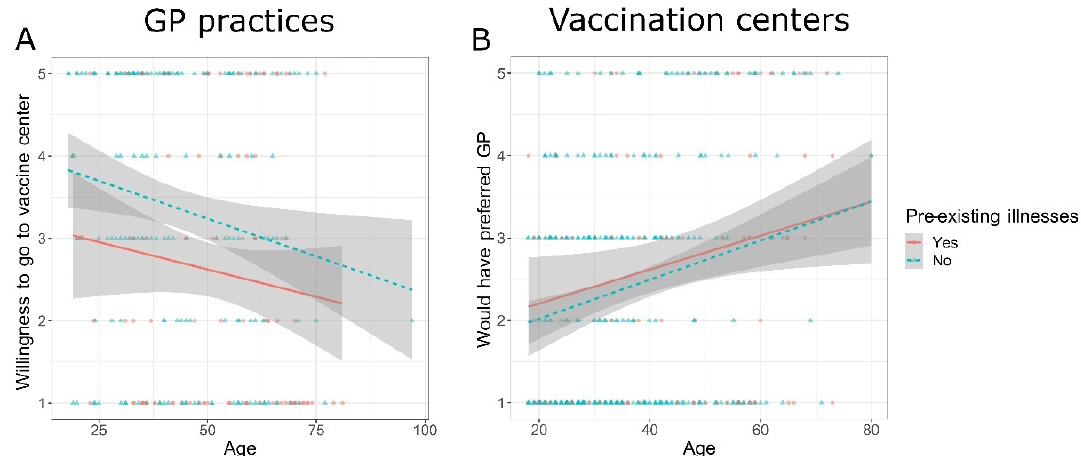
Figure 3. Preference for GPs at both types of sites. Ratings ranged from 1 = Strongly Disagree to 5 = Strongly Agree. ( A ) Participants in GP practices: ANCOVAs revealed that the willingness to receive the vaccine at a vaccination center declined with increasing age of participants ( F (1, 264) = 7.041, p = 0.008, η p 2 = 0.026) and with pre ‐ existing illnesses ( F (1, 264) = 8.953, p = 0.003, η p 2 = 0.033), indicating that pre ‐ existing illnesses influence the willingness to go to a vaccine center independent of age. ( B ) Participants in vaccination centers: The preference to be vaccinated by a GP was higher in older participants ( F (1, 400) = 20.433, p < 0.001, η p2 = 0.049), independent of pre ‐ existing illnesses ( F (1, 400) = 0.438, p = 0.508, η p2 = 0.001).